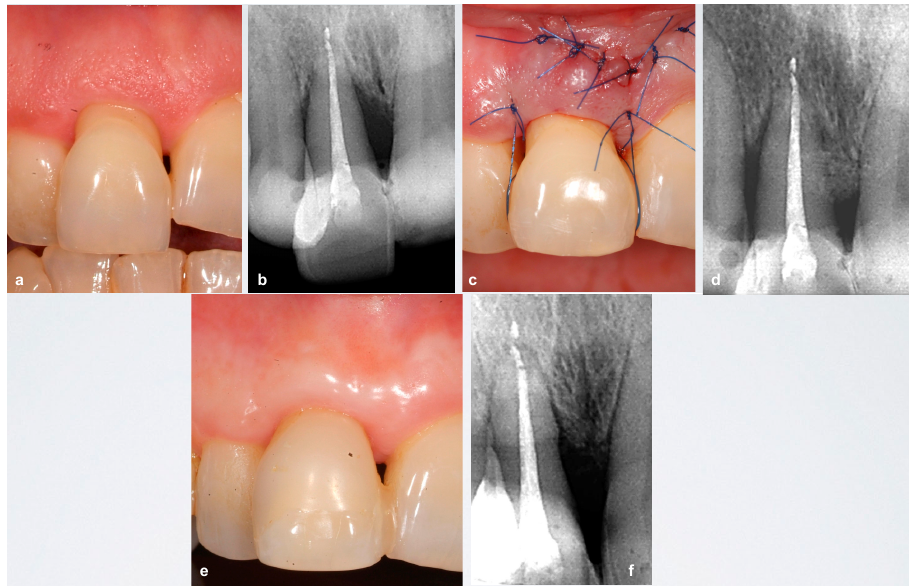
Figure 3. Case 11. ( a , b ) Upper right central incisor extruded with advanced periodontal destruc- tion and grade II mobility with mesial intra-bone defect. ( c , d ) Suture and post-surgical X-ray. ( e , f ) 12 months after surgery. A composite restoration was performed for aesthetic reasons. X-ray: reso- lution of intrabony defect.